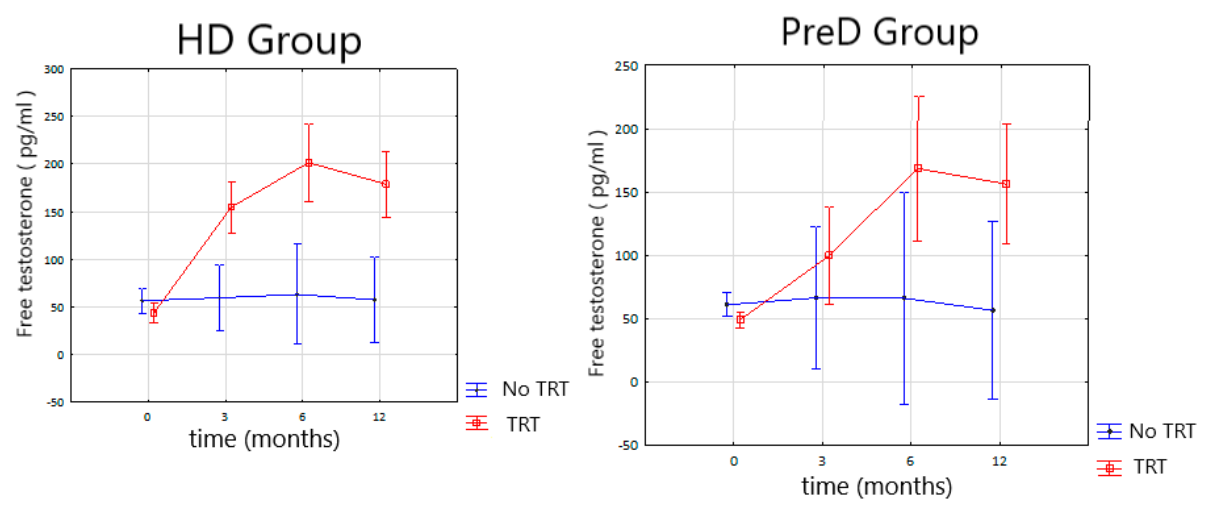
Figure 2. Changes in the free testosterone serum concentration during TRT (testosterone replacement therapy) in HD (hemodialysis) and PreD (predialysis) group. Median LH serum concentrations gradually decreased after 3, 6 and 12 months of observation in HD group in significant manner p = 0.0002. A similar phenomenon was observed in PreD group ( p = 0.0003) (Table